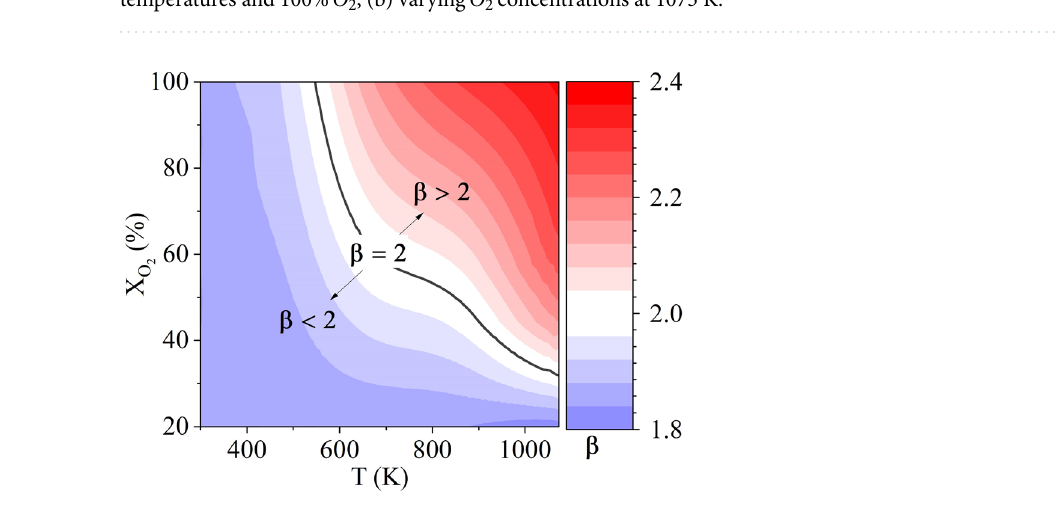
Figure 5. Dependence of initial particle diameter ( d 0 ) on the complete conversion time ( t c ) (a) for different temperatures and 100% O 2 , (b) varying O 2 concentrations at 1073 K.